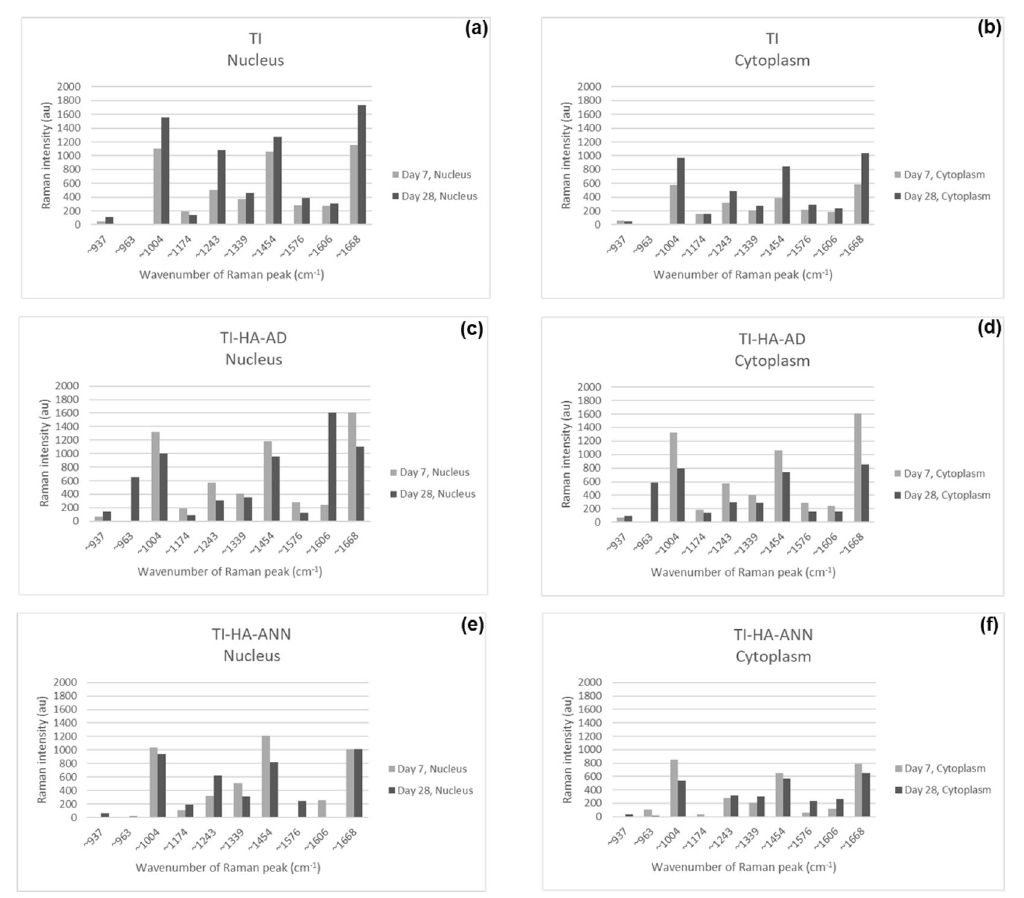
Fig. 6 Averaged processed Raman intensities ( n = 36) as a bar chart for the main Raman peaks (937 – 1668 cm − 1 ) detected in the nucleus ( a , c , e ) and cytoplasm ( b , d , f ) for three random single U-2 OS cells on quartz substrates after 7 (light grey bars) and 28 (dark grey bars) days